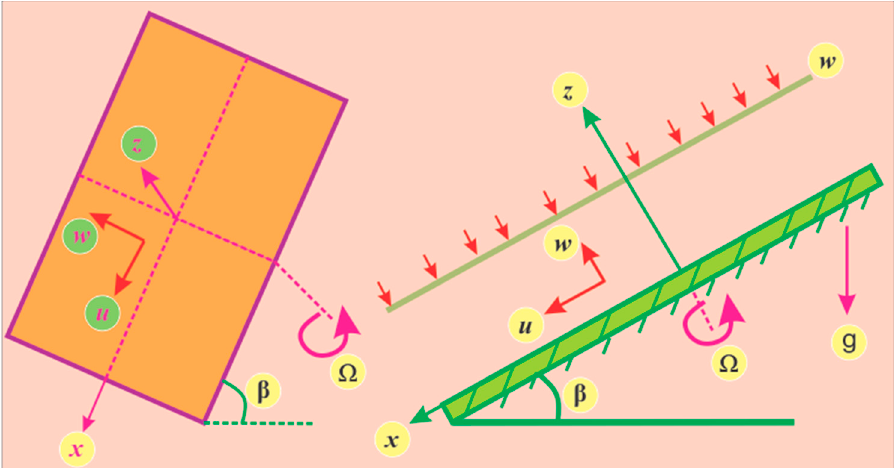
Figure 1. Geometry of the problem.